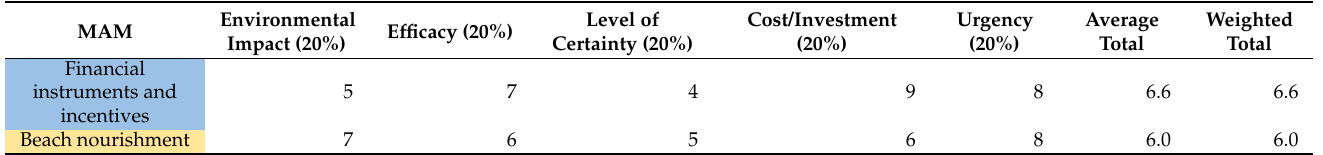
Table 3. Multi-criteria analysis performed by group 1 for each MAM using their 5 elected criteria and respective importance for the weighted calculation. The colored cells represent adaptation (blue) and nourishment (yellow) measures respectively.